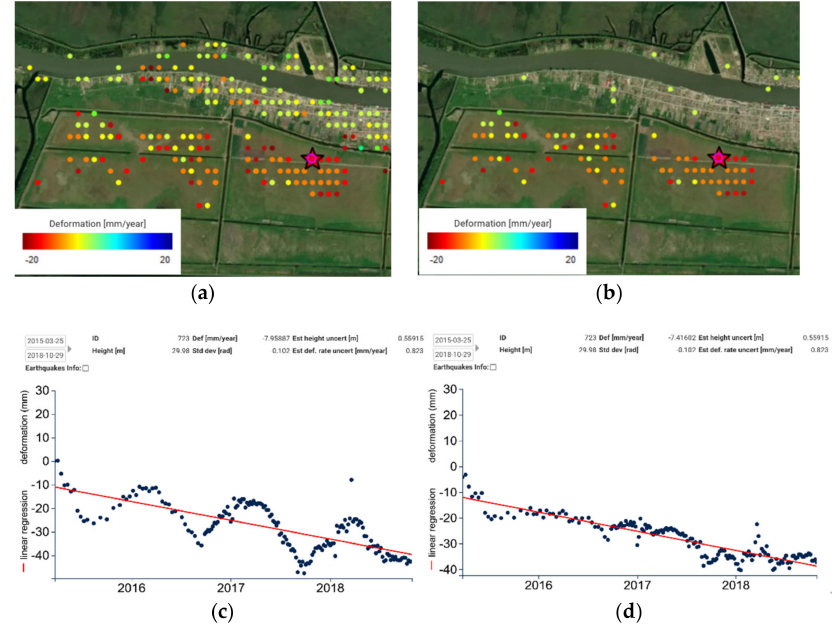
Figure 7. Set of PSInSAR targets and subset of targets affected by seasonal motion: ( a ) PSInSAR motion map in Sulina, Romania; ( b ) areas affected by seasonal motion in Sulina, Romania; ( c ) profile from area Figure 6b affected by seasonal motion (red star); ( d ) seasonal motion removed from the profile in Figure 7c (red